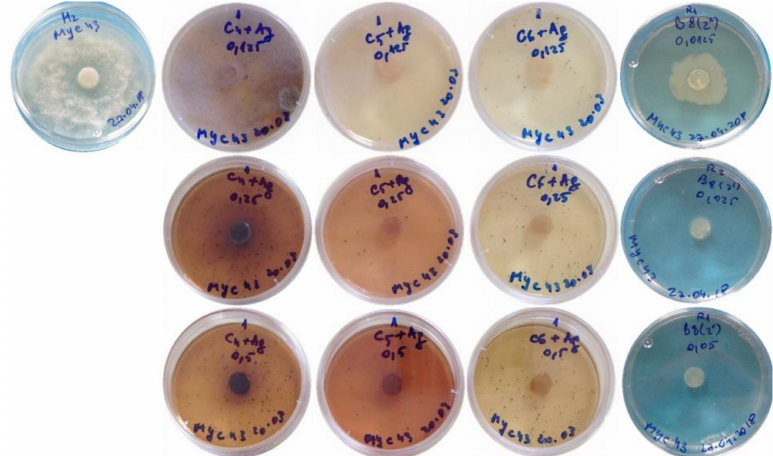
Figure 2. P. cinnamomi growth inhibition assays with the nanocomposites based on the deep eutectic solvent preparation medium. From left to right : Control (no treatment) and treatments with AgNPs combined with gallic acid, silymarin, ferulic acid and curcumin inclusion compounds. From top to bottom : 125 µ g · mL − 1 , 250 µ g · mL − 1 and 500 µ g · mL − 1 concentrations. Only one repetition per treatment is shown. The blue background in the control and curcumin-treated samples is due to the blue color of the paper on which the plates were